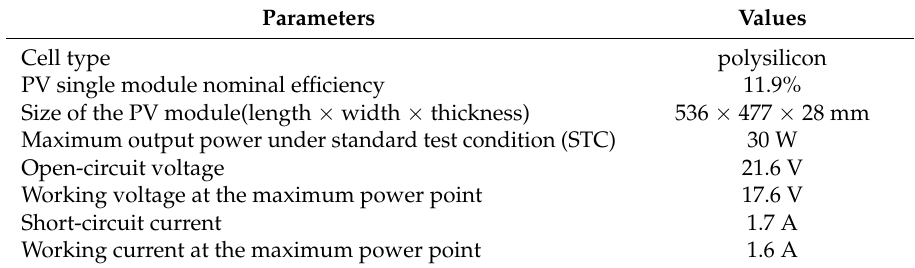
Table 4. Specifications of the photovoltaic (PV) panels utilized for special measurement experiment.